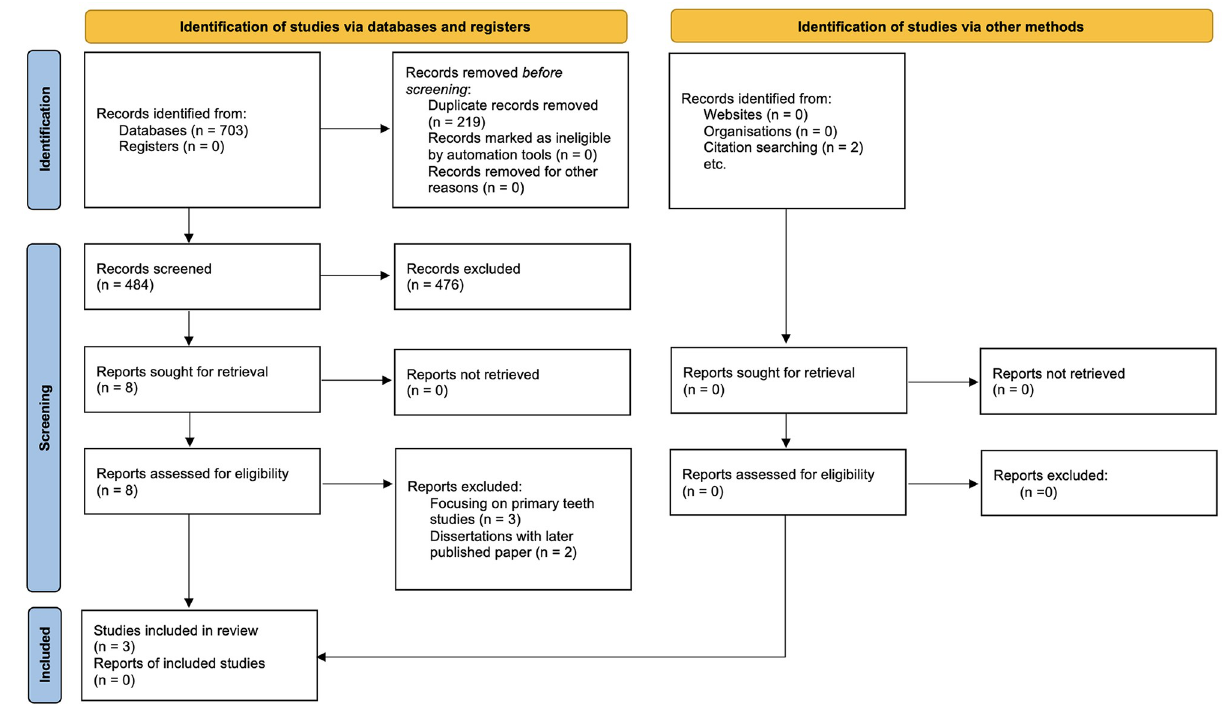
Fig 1. PRISMA 2020 flow